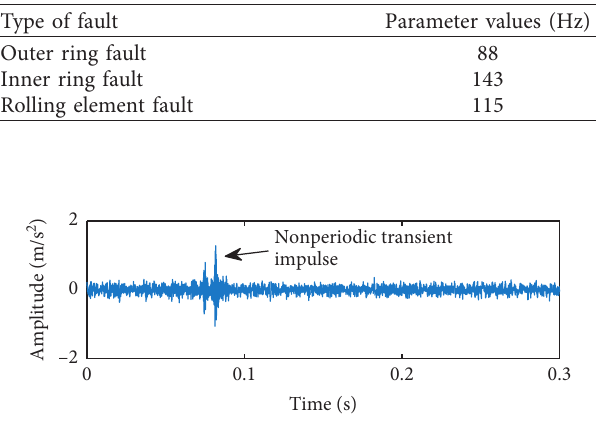
Figure 10: Time-domain waveform of the intercepted experi- mental